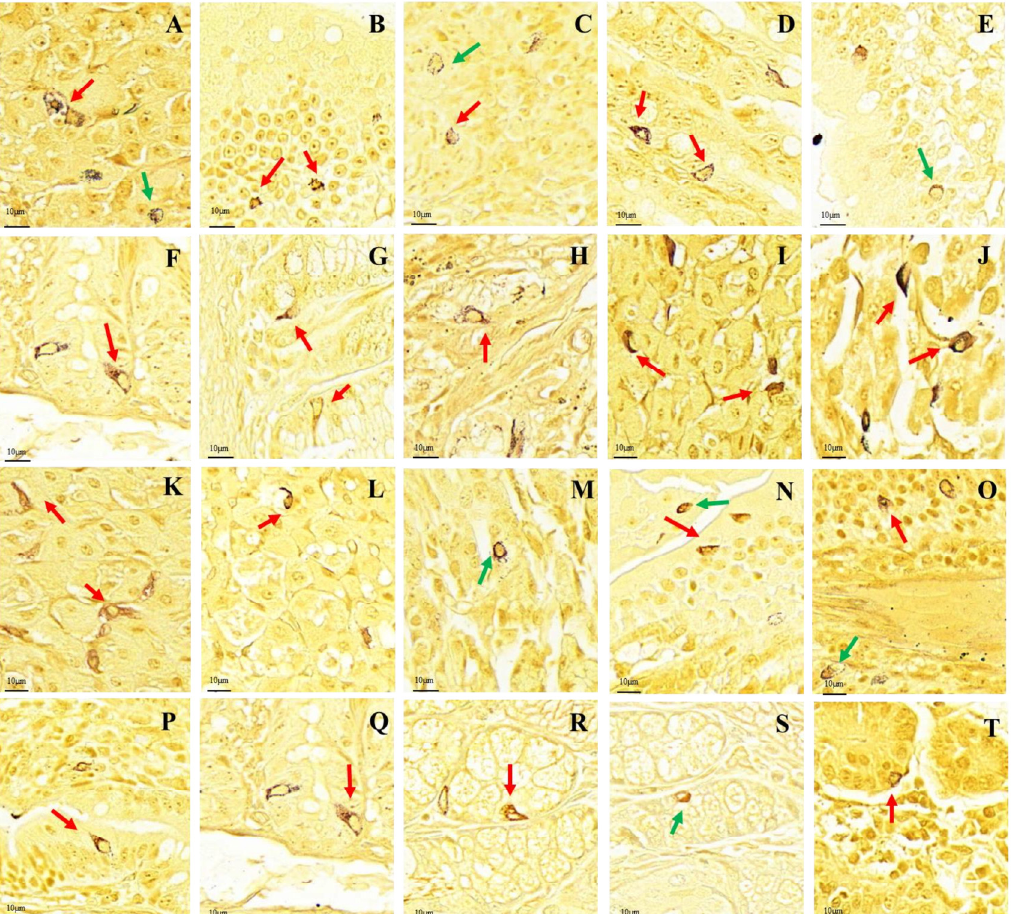
Figure 2. Distribution and morphology of argyrophilic cells in the GIT of the plateau zokor and plateau pika (400× magnification). ( A – H ) Plateau zokor (( A ) round-shaped and cone-shaped argy- rophilic cells in the corpus II of stomach; ( B ) cone-shaped and spindle-shaped argyrophilic cells in the duodenum; ( C ) oval-shaped and cone-shaped argyrophilic cells in the jejunum; ( D ) cone-shaped argyrophilic cells in the ileum; ( E ) round-shaped argyrophilic cells in the ileum; ( F ) cone-shaped argyrophilic cells in the colon; ( G ) cone-shaped and spindle-shaped argyrophilic cells in the rectum; ( H ) cone-shaped argyrophilic cells in the cecum); ( I – T ) plateau pika (( I ) cone-shaped and spindle- shaped argyrophilic cells in the fundus of stomach; ( J ) cone-shaped and spindle-shaped argy- rophilic cells in the corpus I of stomach; ( K ) cone-shaped and spindle-shaped argyrophilic cells in the corpus II of stomach; ( L ) cone-shaped argyrophilic cells in the pylorus of stomach; ( M ) round- shaped argyrophilic cells in the pylorus of stomach; ( N ) oval-shape and cone-shaped argyrophilic cells in the duodenum; ( O ) oval-shape and cone-shaped argyrophilic cells in the jejunum; ( P ) cone- shaped argyrophilic cells in the ileum; ( Q ) cone-shaped argyrophilic cells in the colon; ( R ) cone- shaped argyrophilic cells in the rectum; ( S ) oval-shaped argyrophilic cells in the rectum; ( T ) cone- shaped argyrophilic cells in the cecum). The red arrow indicates opened-type argyrophilic cells and the green arrow indicates closed-type argyrophilic cells.